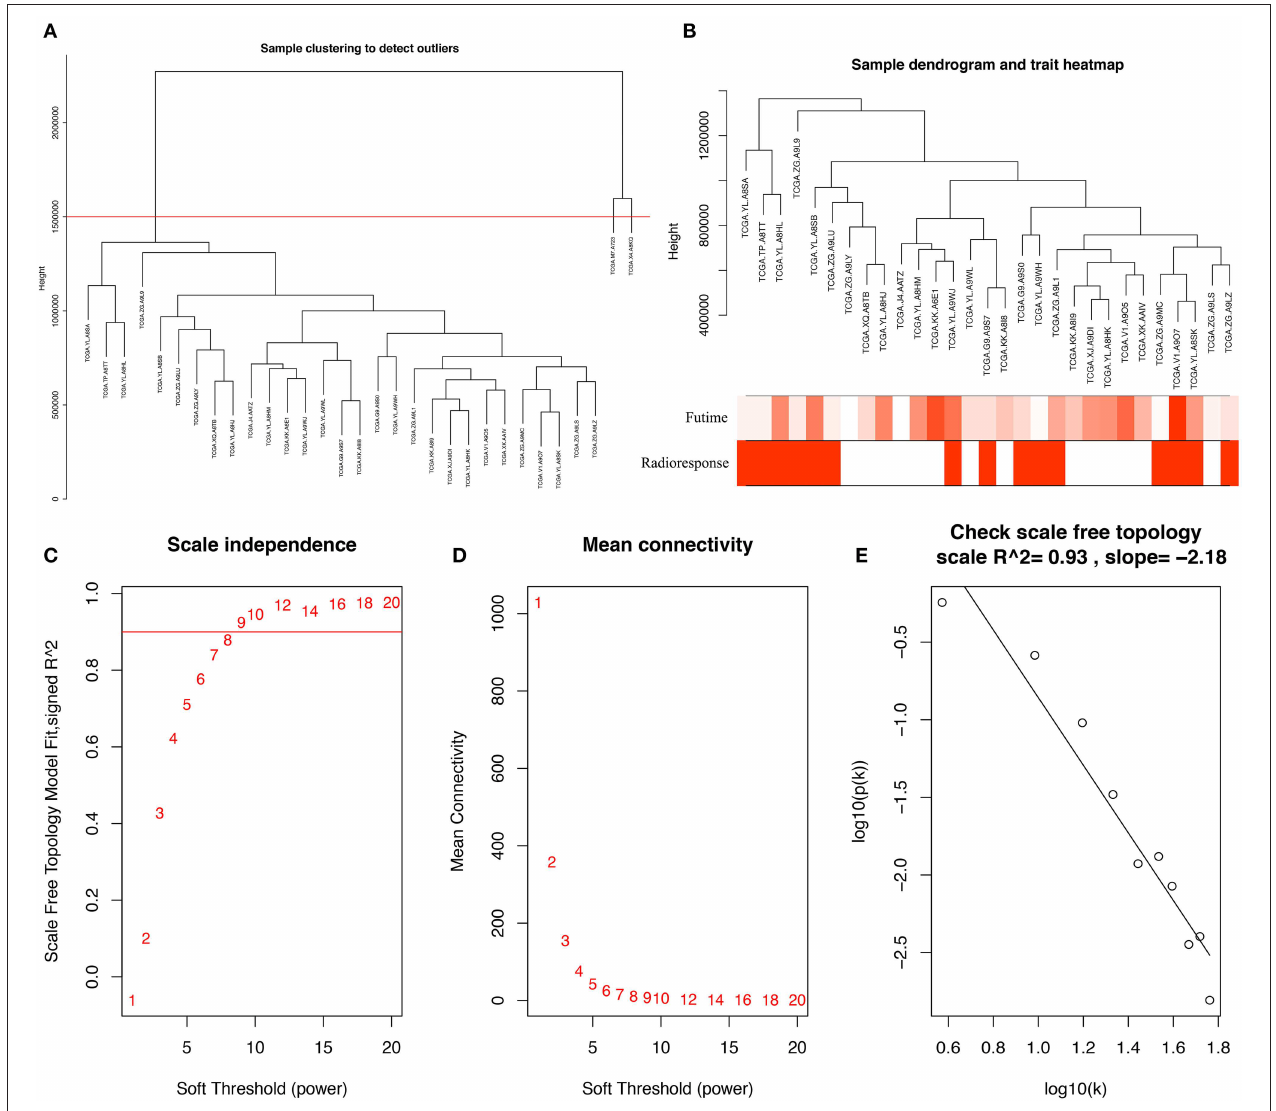
FIGURE 1 | (A) Clustering dendrogram of 31 samples, and excluding two outlier sample. (B) Clustering dendrogram of 29 samples corresponding to clinical characteristics. (C) Analysis of the scale-free fit index for various soft-thresholding powers ( β ). (D) Analysis of the mean connectivity for various soft-thresholding powers. (E) Checking the scale-free topology when β =